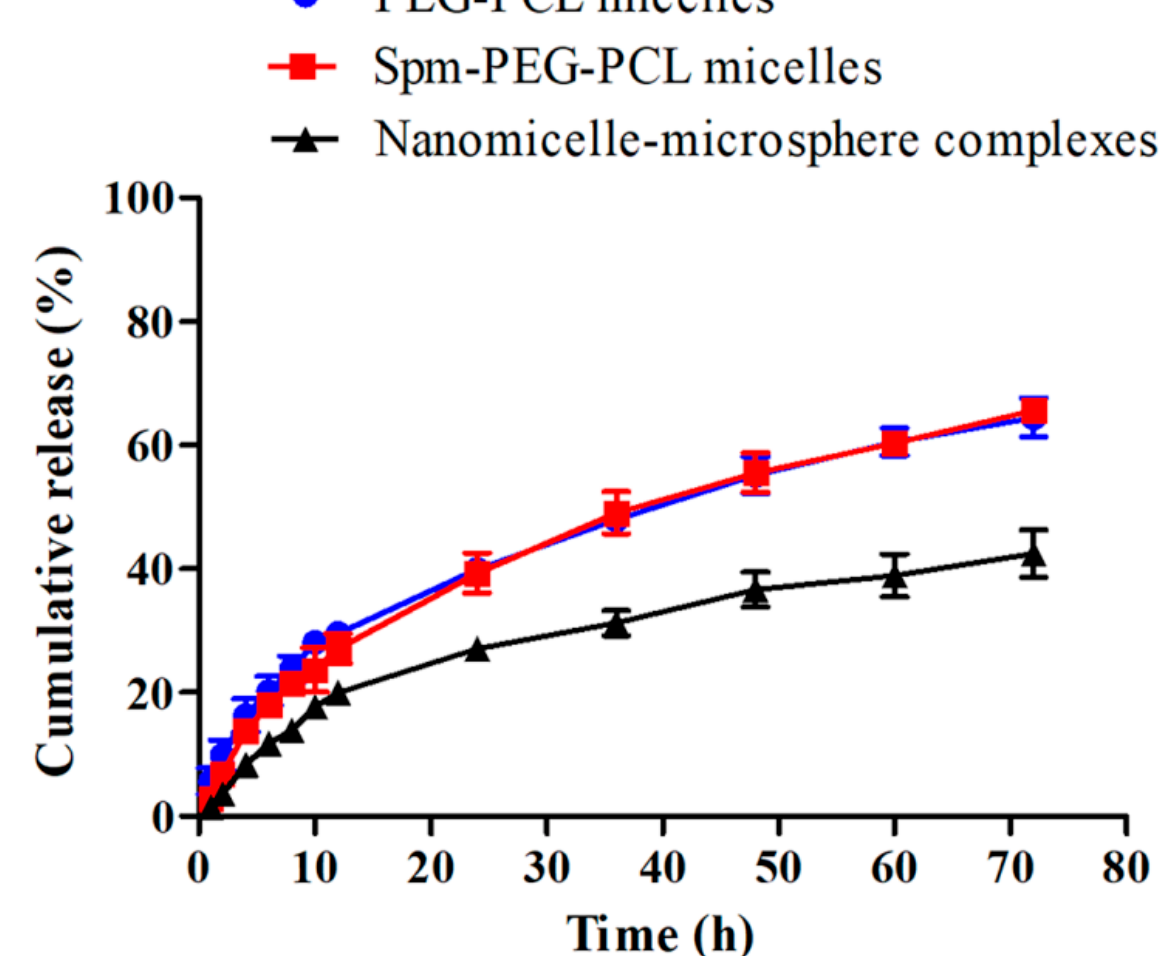
Figure 5. In vitro release of DOX from two micelles and the nanomicelle-microsphere complexes at pH 7.4 ( n = 3).